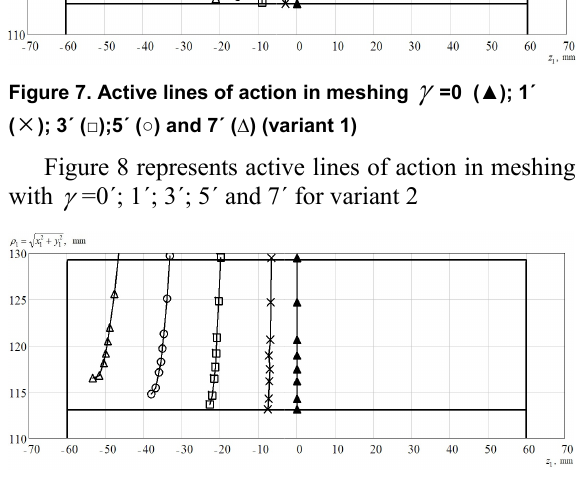
Figure 8. Active lines of action in meshing γ =0 ( ▲ ); 1´ ( × ); 3´ ( □ );5´ ( ○ ) and 7´ ( ∆ ) (variant